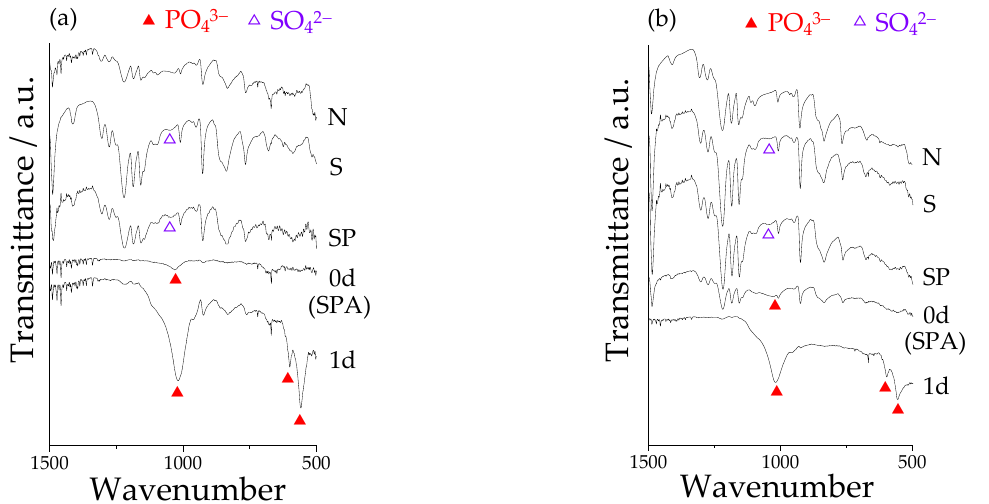
Figure 6. FT-IR spectra on the surface of Samples N: untreated PEEKs, S: sulfuric acid-treated PEEKs, SP: sulfuric acid + oxygen plasma-treated PEEKs, and SPA: sulfuric acid + oxygen plasma + modified-SBF-treated PEEKs before (denoted as “0d”) and after immersion in SBF for 1 day (denoted as “1d”) for ( a ) pure PEEK and ( b ) 50C-PEEK .